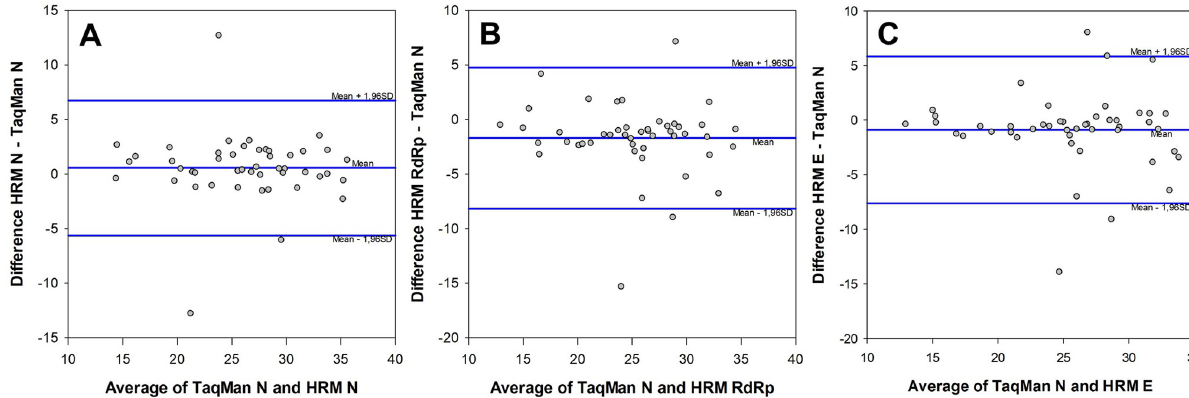
Fig 4. Bland-Altman plots resulting from the pairwise comparison of Ct values between RT-qPCR TaqMan and HRM-RTqPCR assays targeting SARS-CoV-2 N, RdRp and E. A. TaqMan N x HRM N targets. B. TaqMan N x HRM RdRp targets. C. TaqMan N x HRM E targets. Level of agreement between two assays, also known as observed mean difference (blue line at center), is presented as a function of the average Ct values of the two assays. Upper and lower limits of agreement (Upper and lower blue lines, respectively) defined by mean Ct difference ± 1.96 Standard Deviation (SD). The bias observed were 0.56, -1.71 and -0.89 to A, B and C,